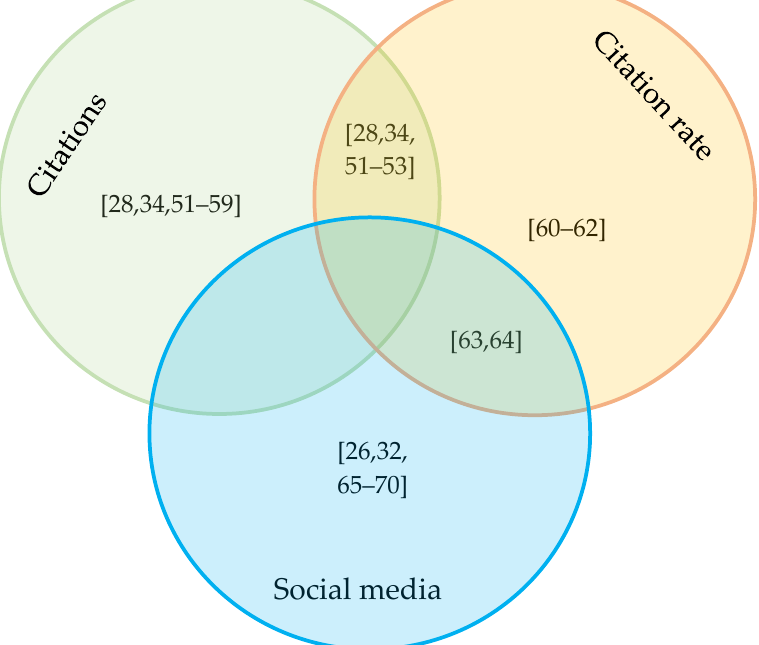
Figure 6. A Venn diagram to represent the top 10 papers on the TNR topic determined by each of citations (total citations received) [28,34,51–59], citation rate (citations / year) [28,34,51–53,60–64], or social media mentions [26,32,63–70]. Note that the citations list actually includes 11 papers, because two papers tied for tenth spot on the list. The numbers in parentheses correspond to references, the full details of which can be found by number in the reference list at the end of the paper. The Venn diagram indicates all the papers in each list within the respective circles. Papers listed in the overlap regions between circles are in common to two lists: five are in common between the citations list and the citation rate list, and two are in common between the citation rate list and the social media list. No papers are in common to all three